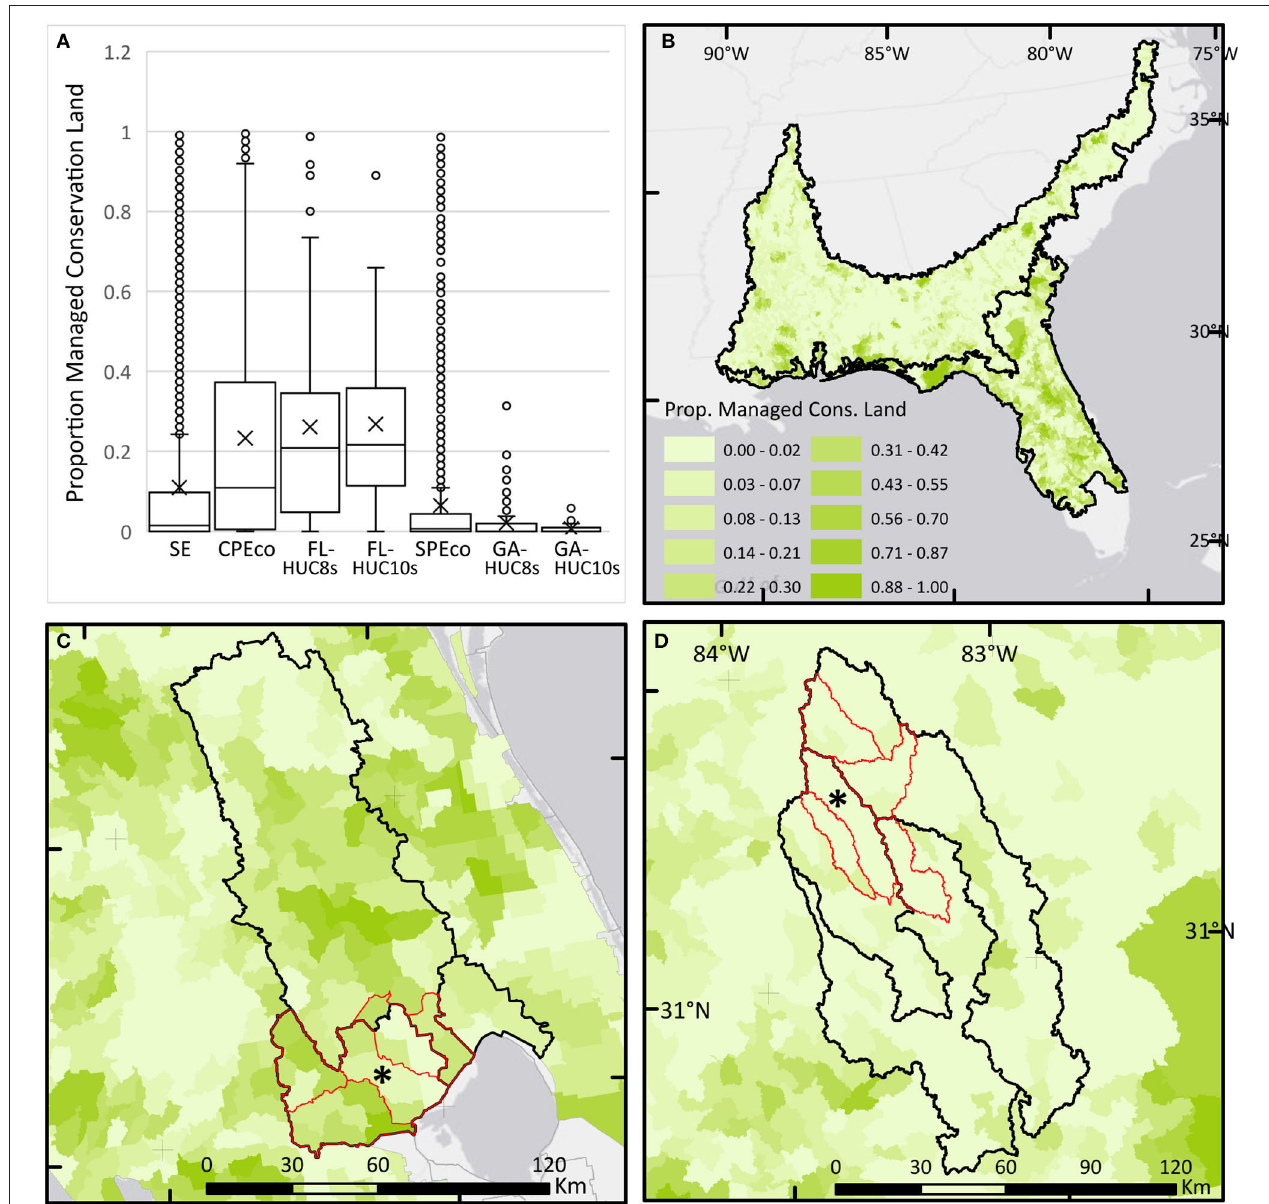
FIGURE 9 | Boxplots and maps of percent area of lands protected for conservation calculated for HUC-12 areas and summarized for each study area (clockwise from top left). Asterisk (*) shows location of LTAR sites. (A) Boxplots of percent area of lands protected for conservation for each study area. (B) Map of percent area of lands protected for conservation calculated for HUC-12s in the Southeast (SE). (C) Map of percent area of lands protected for conservation calculated for HUC-12s in the Florida study areas. (D) Map of percent area of lands protected for conservation calculated for HUC-12s in the Georgia study areas.